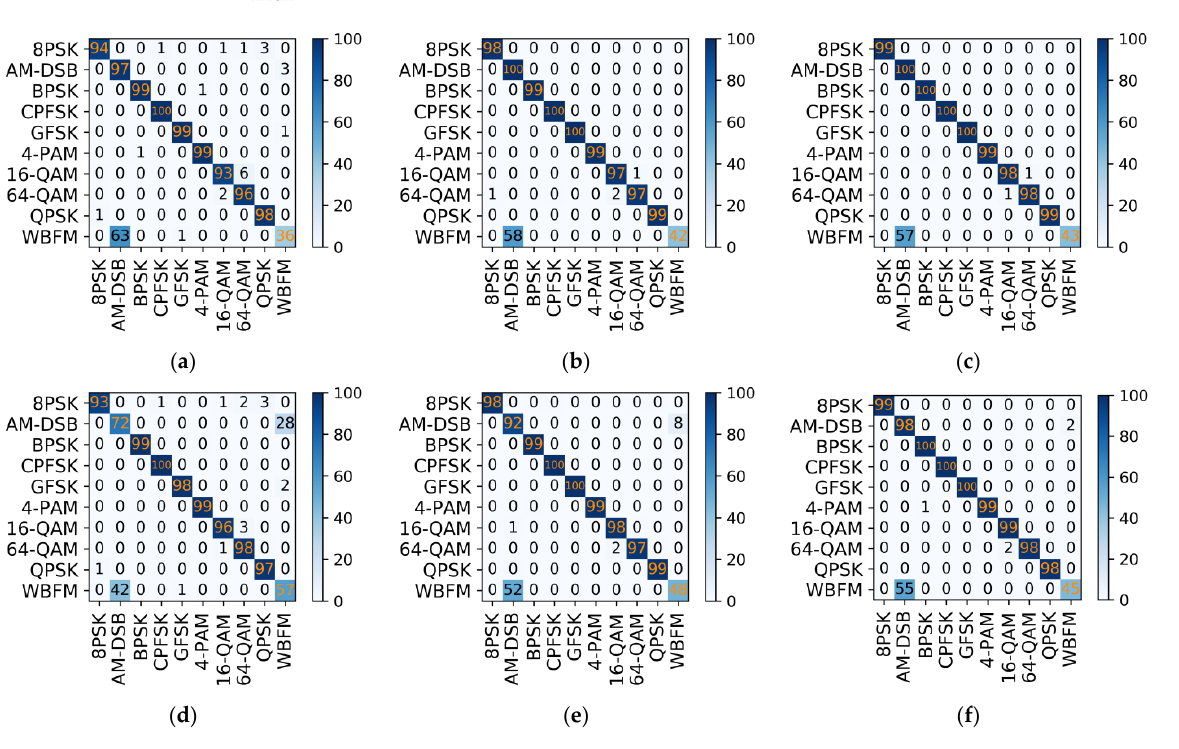
Figure 13. Partial confusion matrices on the RML2016.10b dataset about two networks. ( a ) IQGMCL- 0dB; ( b ) IQGMCL-4dB; ( c ) IQGMCL-12dB; ( d ) MCLDNN-0dB; ( e ) MCLDNN-4dB; ( f ) MCLDNN-